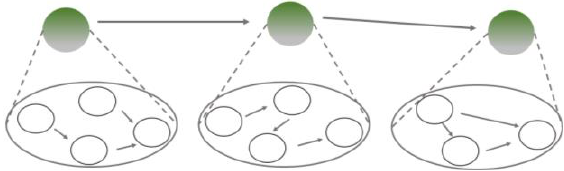
Figure 4. Mechanisms underlying components of a productive mechanism.